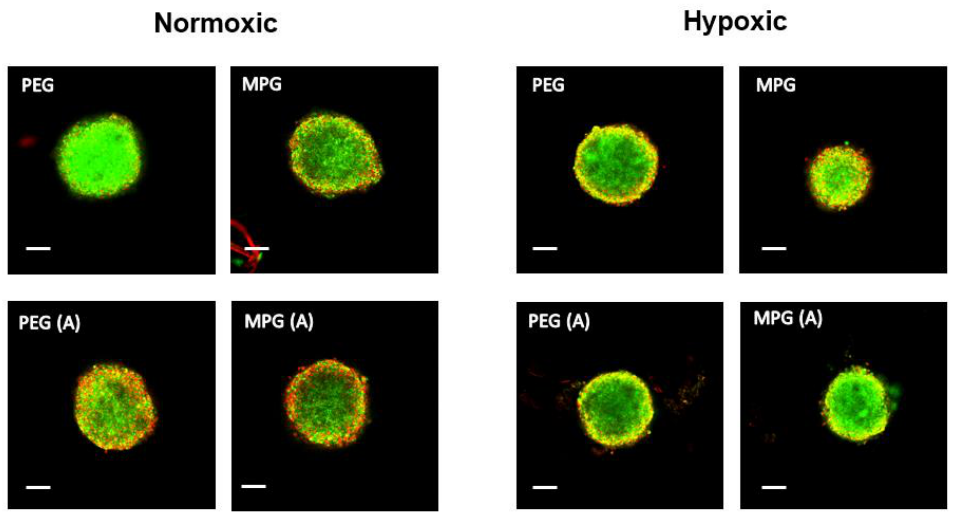
Figure 4. Representative fluorescence images of non-PMX spheroids including nonactivated and activated cells cultured in both normoxic and hypoxic conditions. Spheroids were incubated with 50 μg/mL NPs for 24 h after 5 days in culture. Green channel represents coumarin 6 NPs while red represents DAPI stained cells. Scale bars represent 100 μ m.